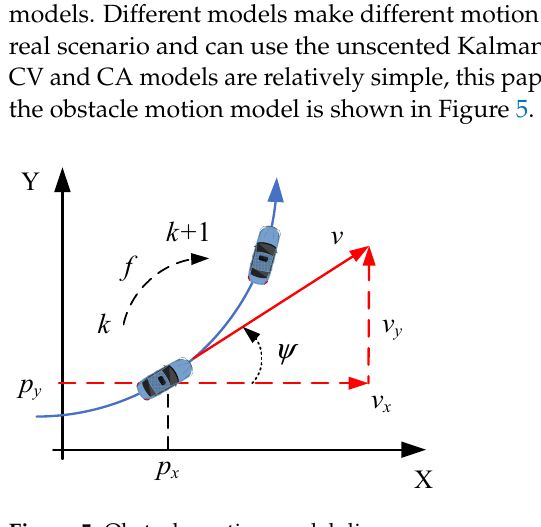
Figure 5. Obstacle motion model diagram.